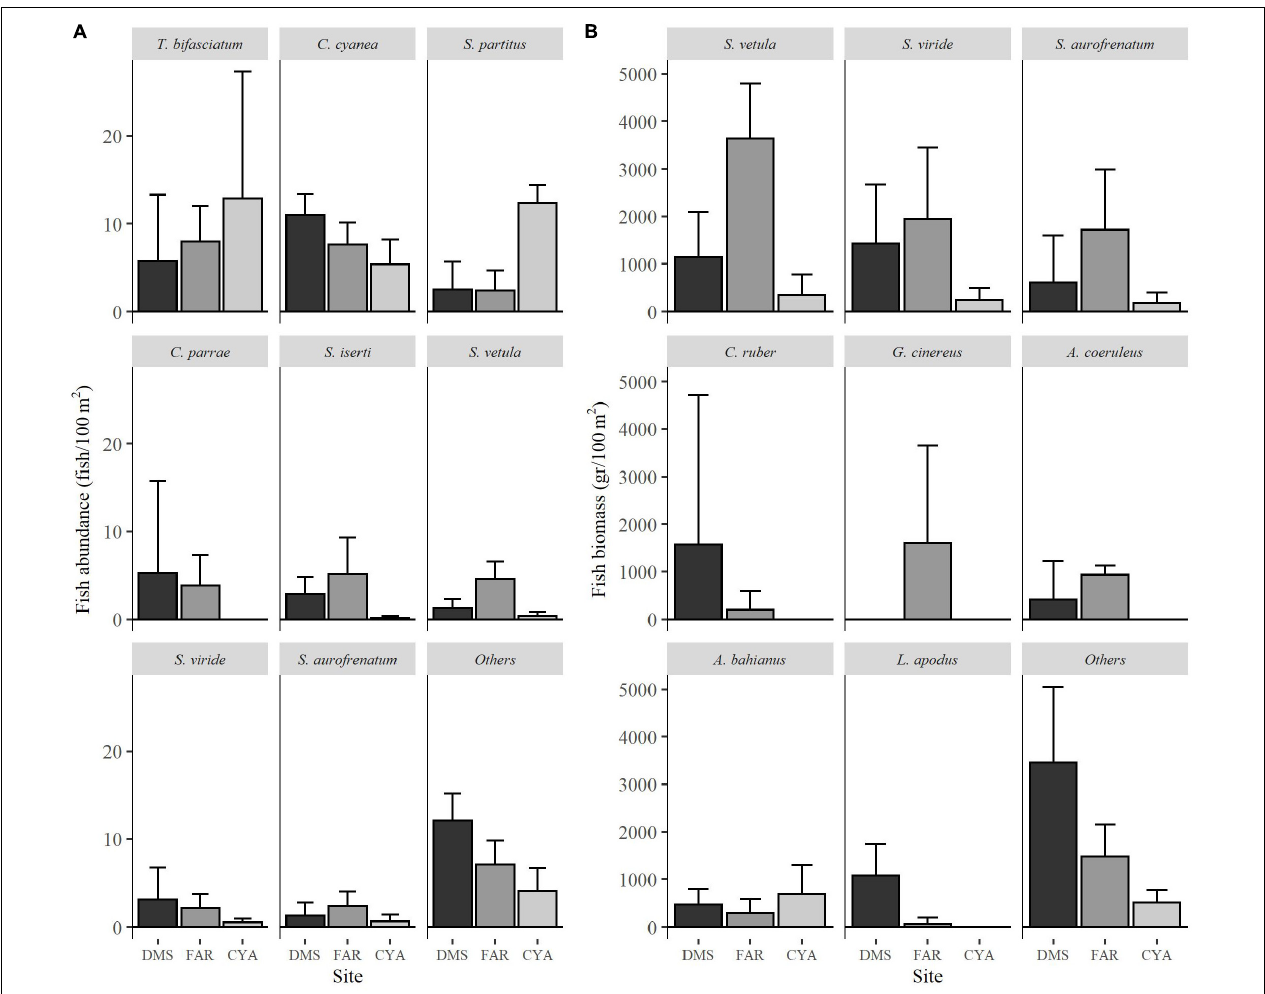
FIGURE 2 | Abundance (number of individuals per 100 m 2 ; A ) and biomass (gr. per 100 m 2 ; B ) of the species composing 85% of the total abundances and biomass of fish. The planktonic species C. multilineata was not included for better visualization of the figure because of a single, large school ( > 600 individuals) was observed in Dos Mosquises. This species alone represented a 42% of total abundance of